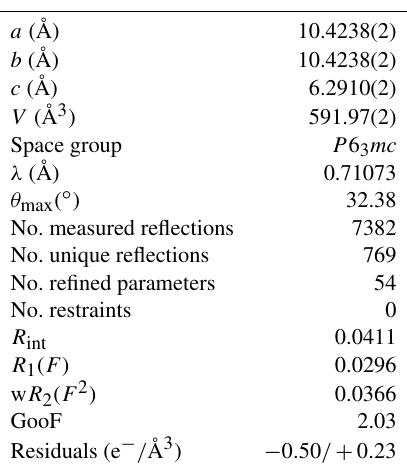
Table 2. Details pertaining to the data collections and structure re- finements in ambient conditions of the burbankite studied in this